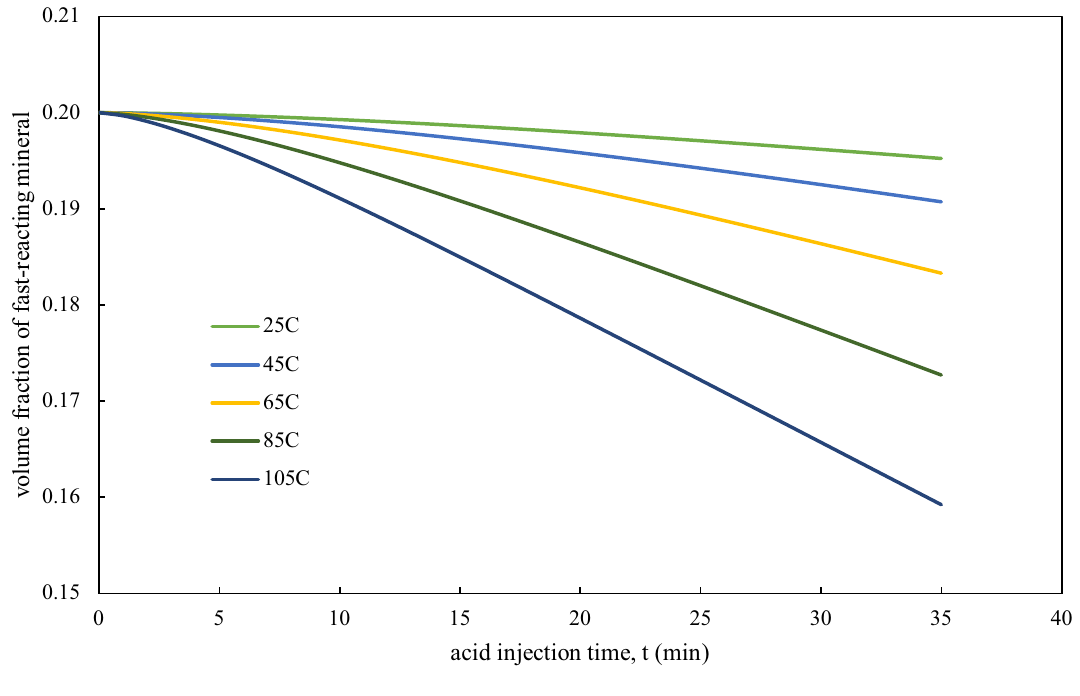
Fig. 19 The effect of temperatures on fast-reacting mineral composition over injection